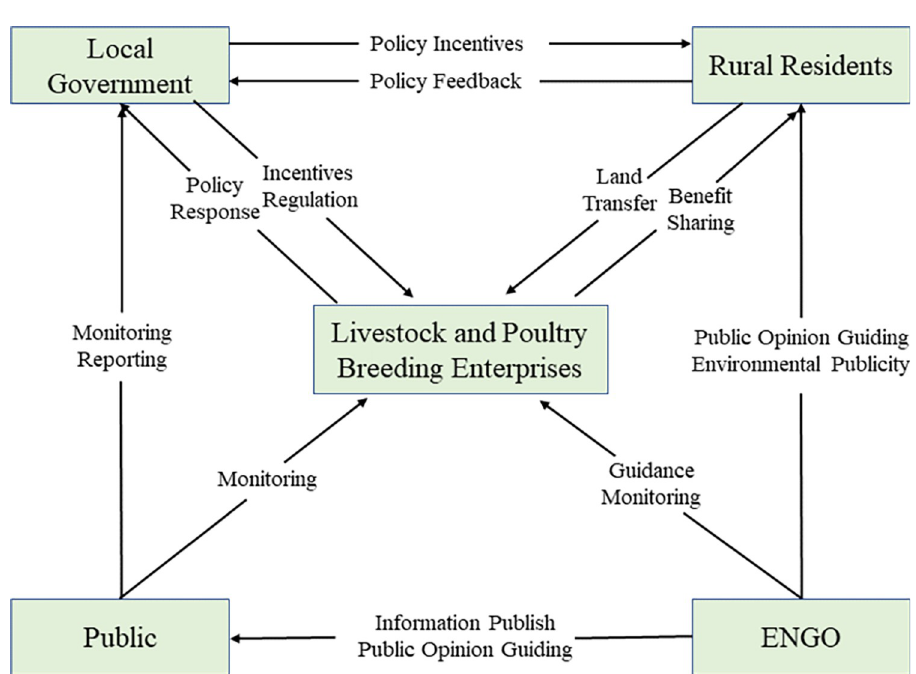
Fig 1. Multiple co-governance paths for agricultural non-point source